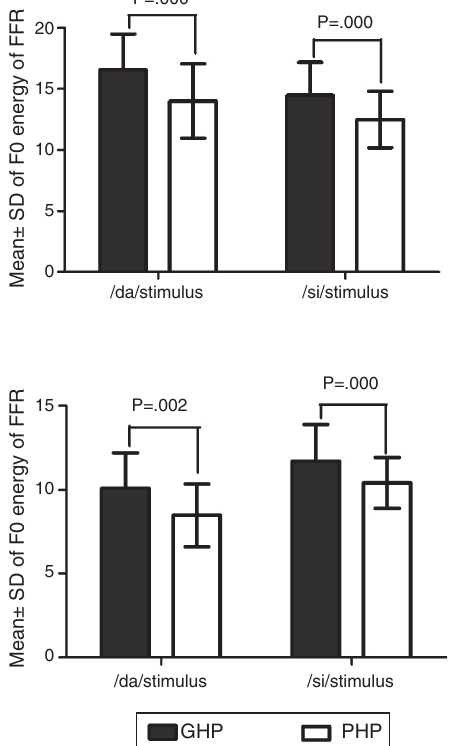
Figure 8 Mean and standard deviation of F 0 energy and F 1 energy for each stimulus in GHP and PHP